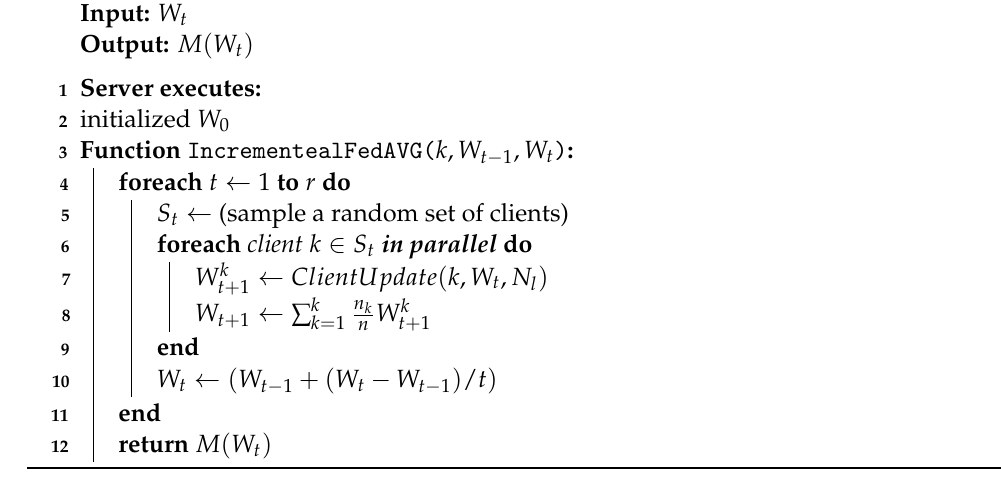
Algorithm 1: Incremental FedAVG algorithm. k : Number of clients, r : Number of rounds, W i : Local model weights and M : Global model weights.